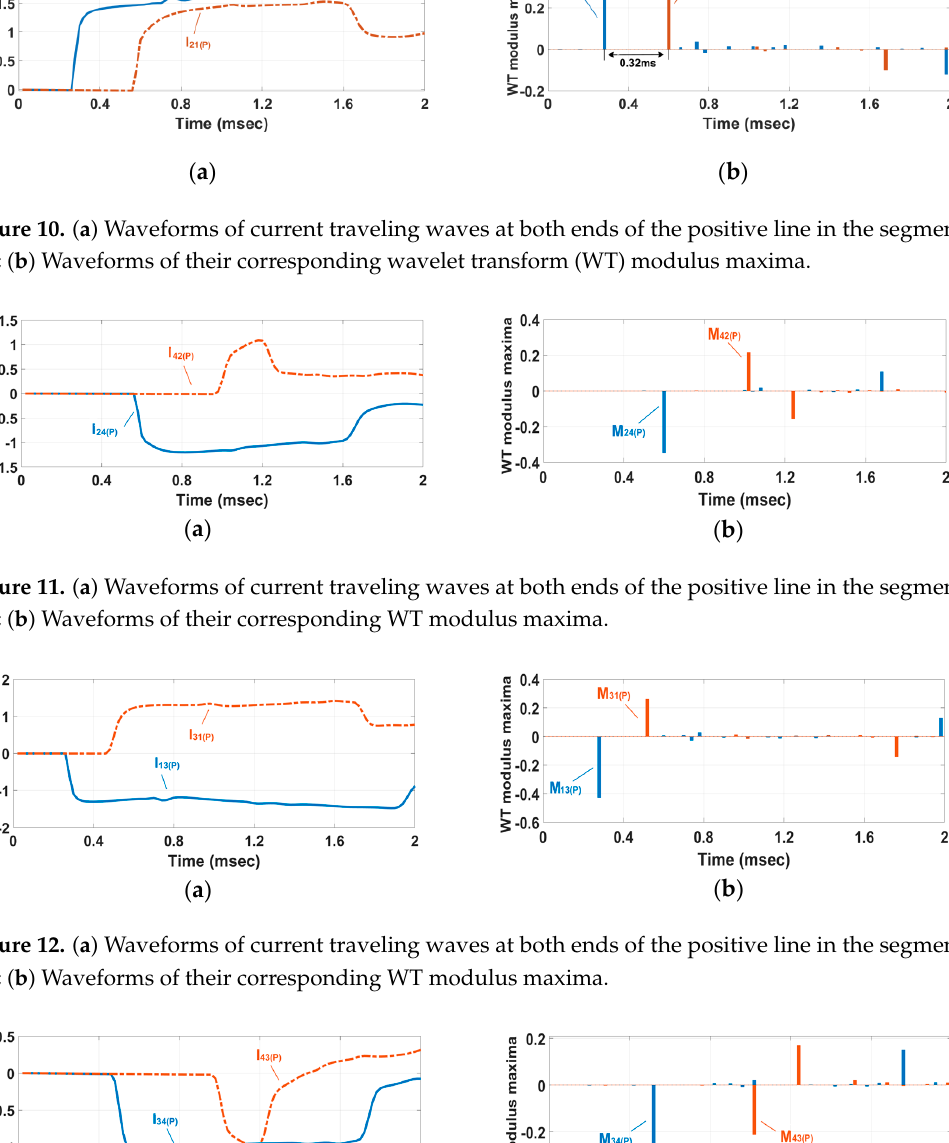
f Figure 9. Simulation model for the Zhangbei MMC-HVDC power grid. 4.2. Typical Fault Simulation 4.2.1. Metallic Single-Pole-Ground Fault Without loss of generality, a metallic positive-pole-ground fault is set at f where is 68.1 km